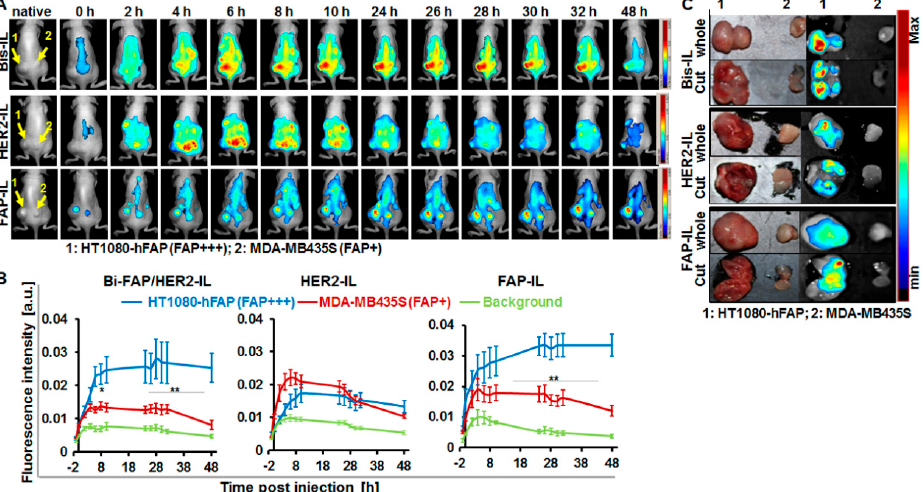
Figure 7. NIRF-imaging of FAP-expressing tumor models as a measure of cargo-release by FAP’ and HER2’scFv-bearing liposomes. ( A ) Representative in vivo NIR-fluorescence images of mice bearing stable human FAP-expressing fibrosarcoma HT1080-hFAP (FAP+++, left) and endogenous FAP-expressing human melanoma MDA-MB435S (FAP + , right) acquired with the red filter